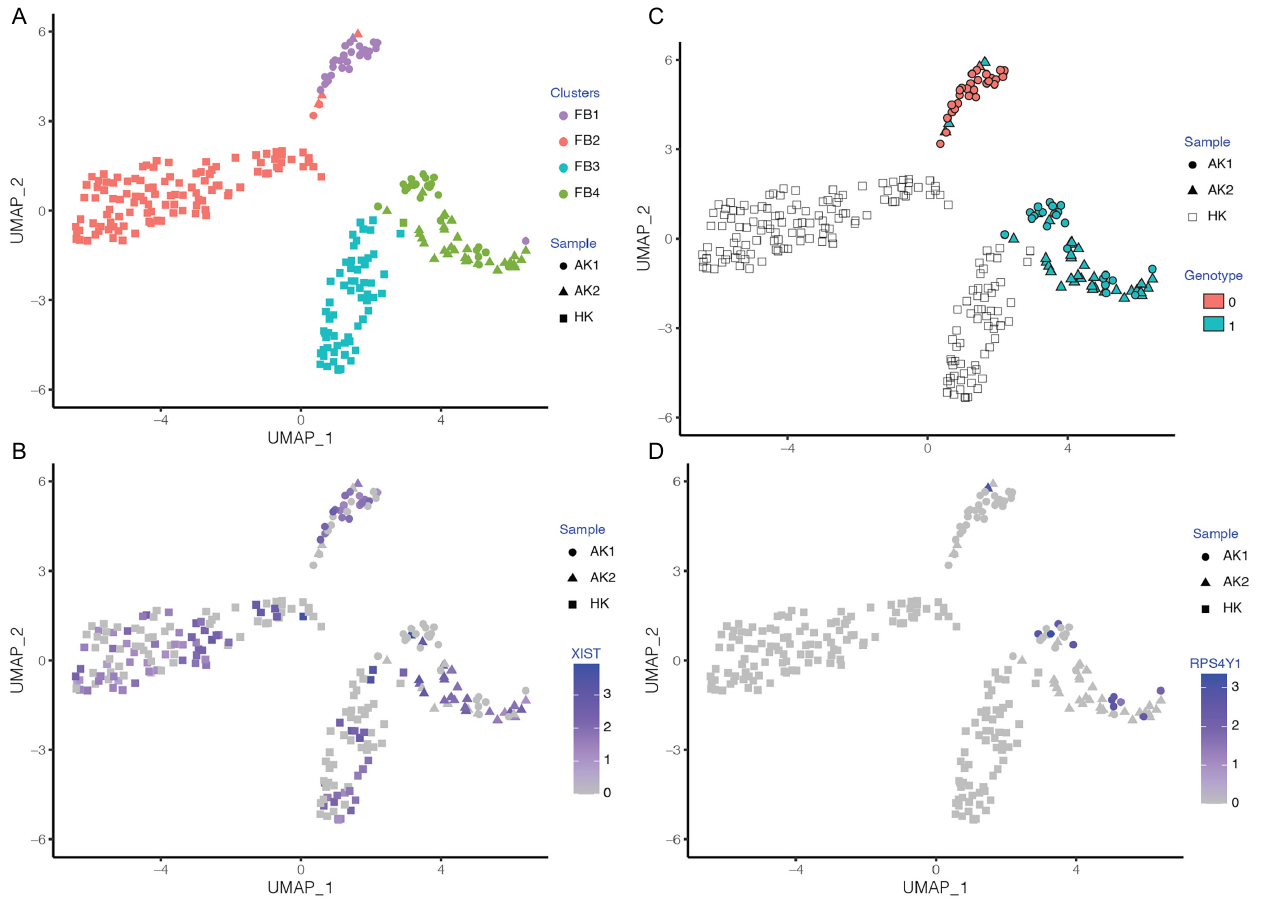
Fig 4. Visualization of fibroblast subpopulations clustered based on donor/recipient sex and clustered based on their genotype. (A). Fibroblast subpopulations. (B). Fibroblast subpopulations visualized based on their expression of female-specific gene XIST. (C). Fibroblast subpopulations visualized based on their expression of male-specific Y chromosome autosomal gene RPS4Y1. (D). Fibroblast subpopulations visualized based on their genotype clusters.